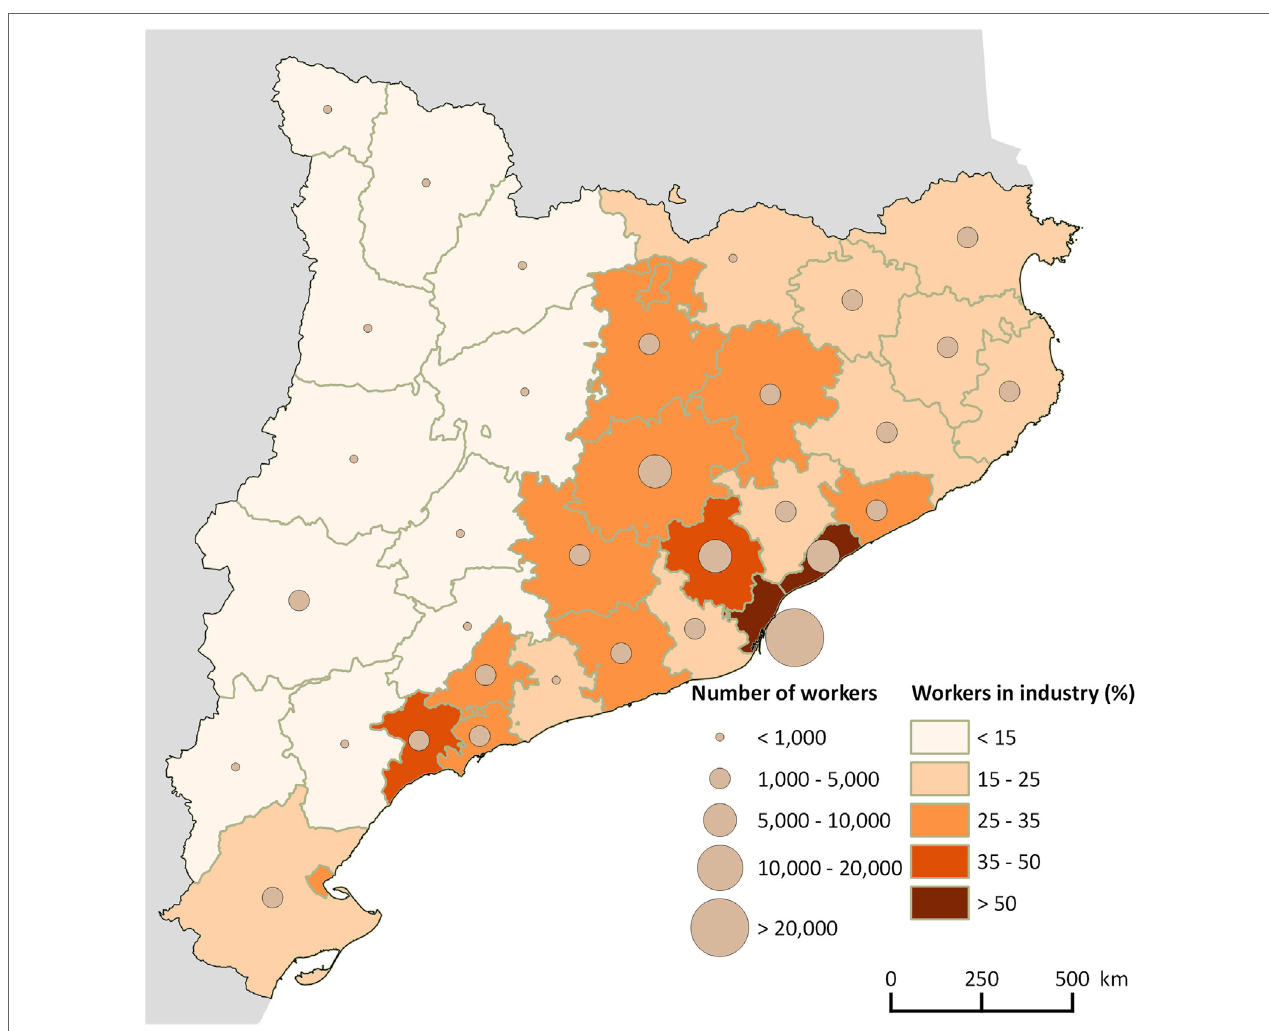
FigUre 7 | Total and % of industrial workers over the total occupied population in Catalonia in 1860, by judicial party. This figure does not include artisans. Source: Own